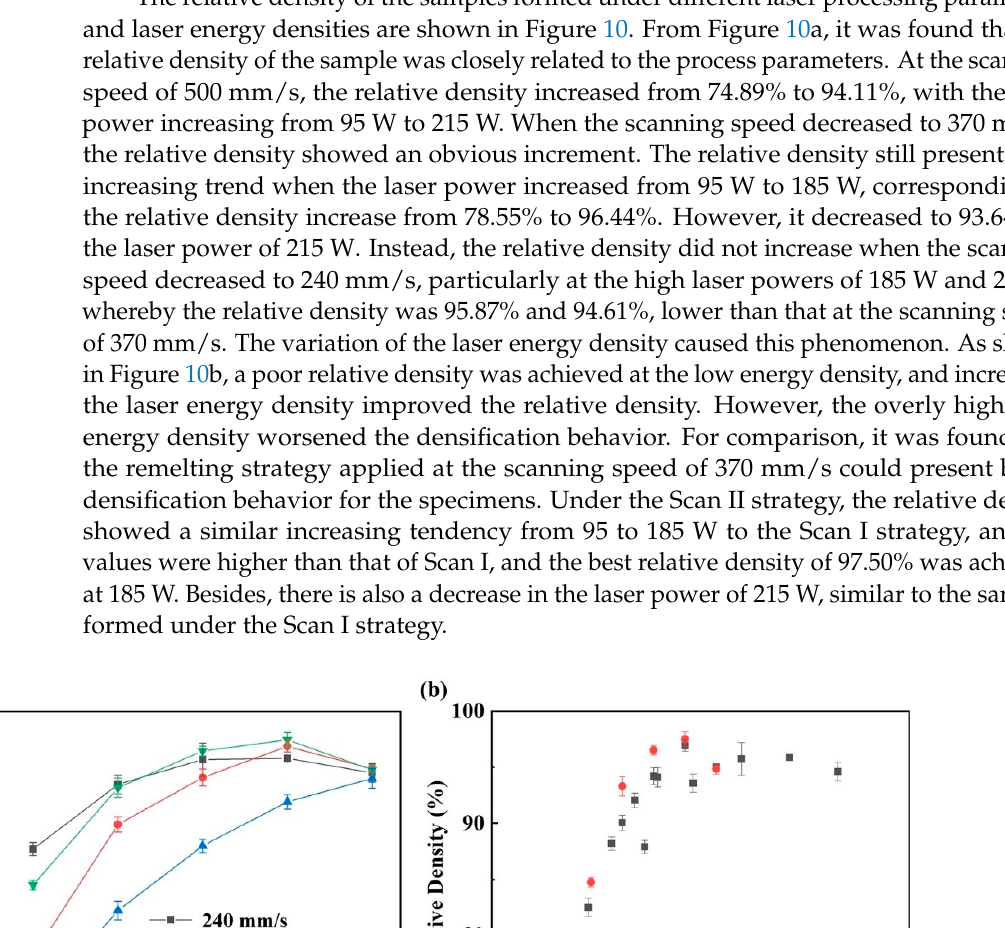
Figure 9. The surface profiles were obtained along the x-direction on the surface in Figure 8: ( a ) 95 W, 500 mm/s, scan I; ( b ) 125 W, 370 mm/s, scan I; ( c ) 215 W, 370 mm/s scan I; ( d ) 215 W, 370 mm/s, scan II.